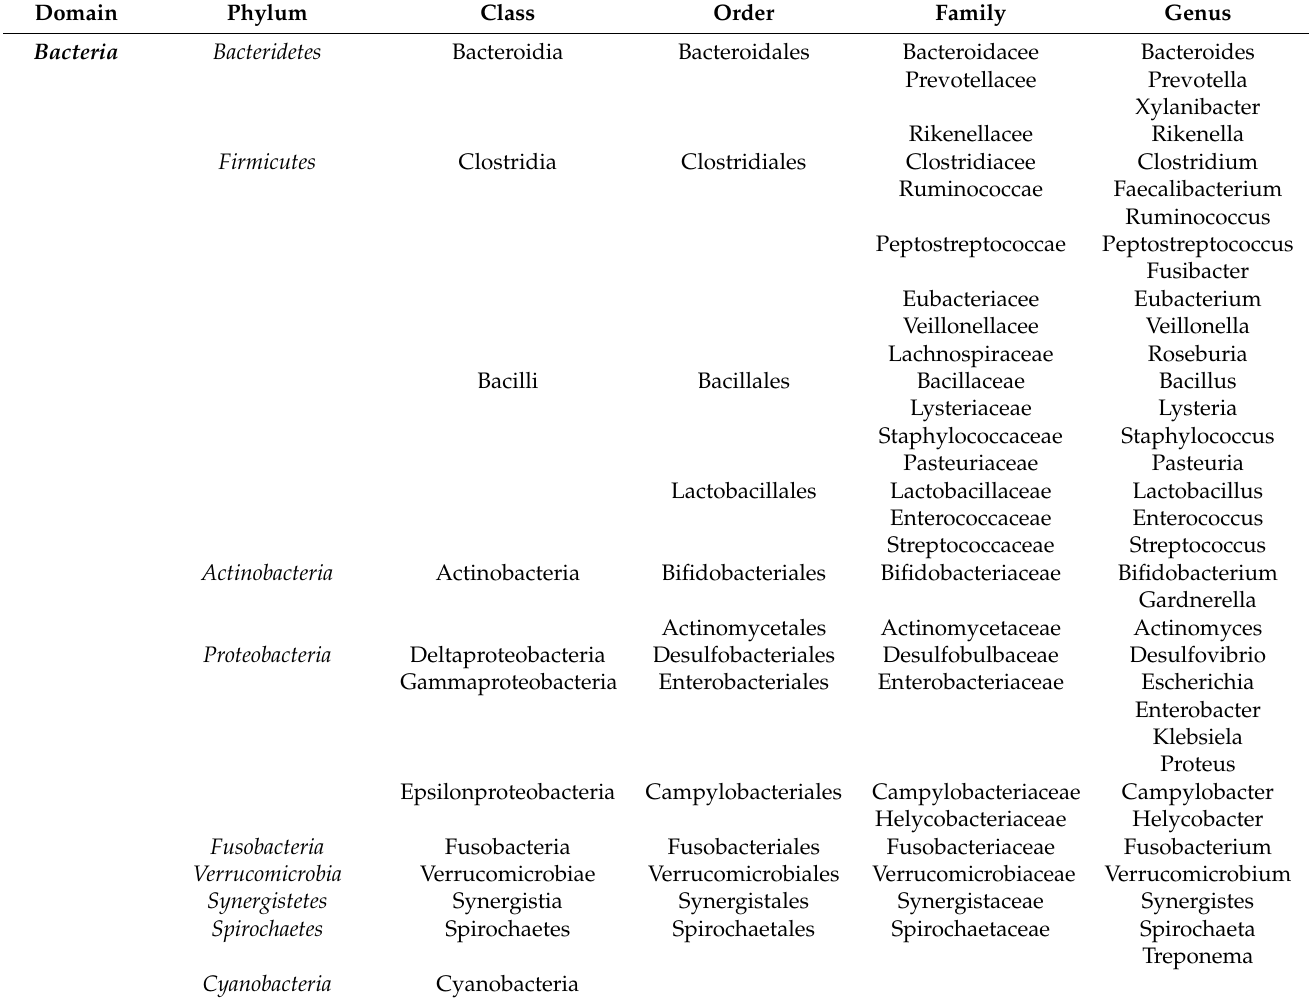
Table 1. Major bacteria in the human gut